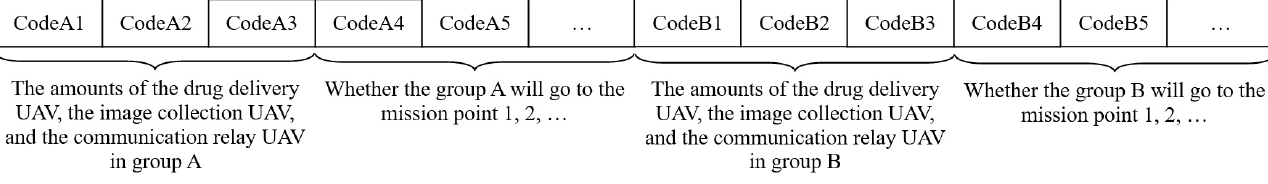
Figure 7. Sketch map of the chromosome coding method of